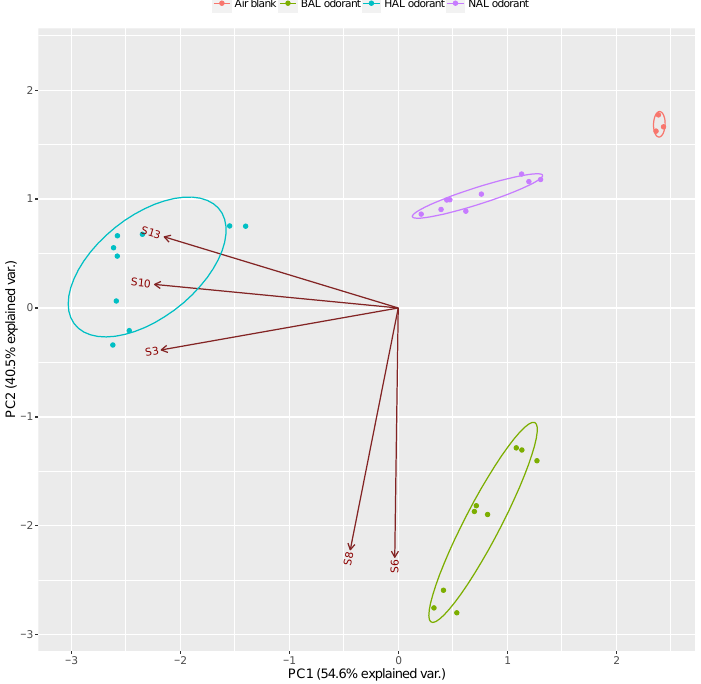
Figure 7. PCA map based on the optimized sensor array.